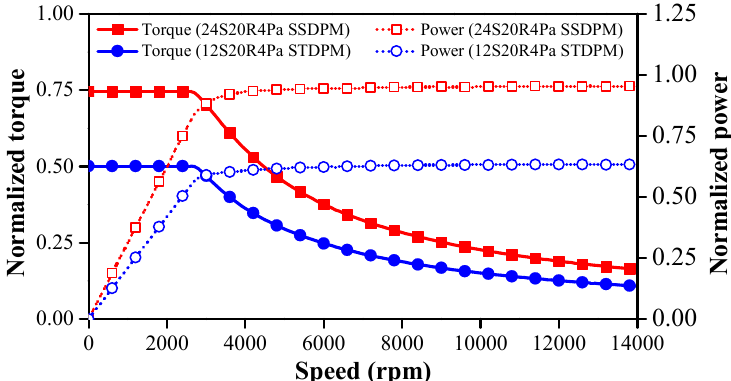
Figure 25. Torques/powers versus speed of two dual-PM machines.